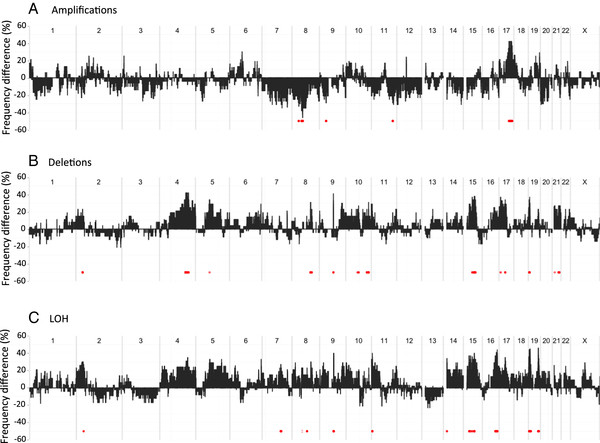
Differences in frequency of tumors with aberrations between tumor with and without recurrence across the genome. Gains (total copy number 3 and higher) (A). Total copy number 1 (B) and LOH irrespective of total copy number (C).